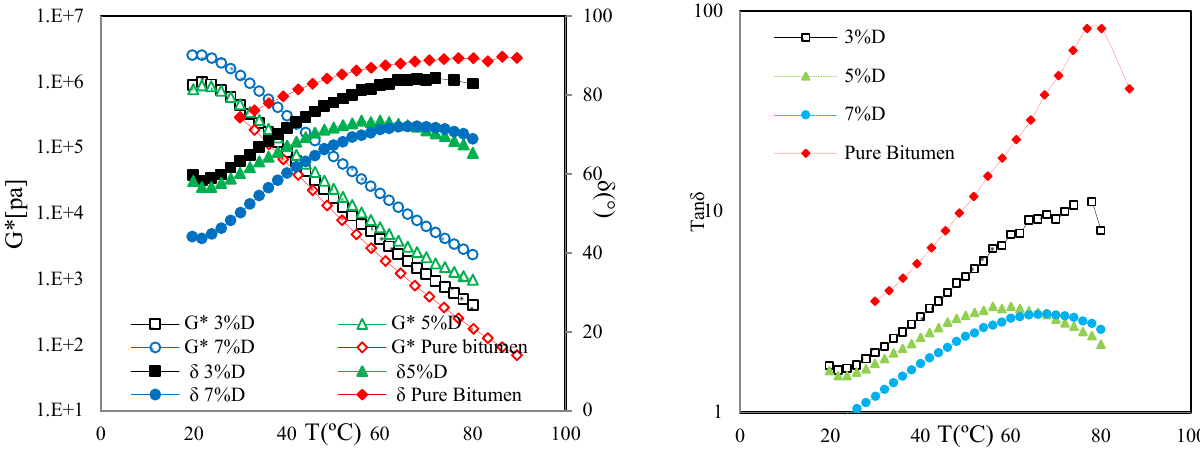
Fig. 4. Complex modulus/phase angle (left) and Tanδ (right) curves for the bitumen modified by blend